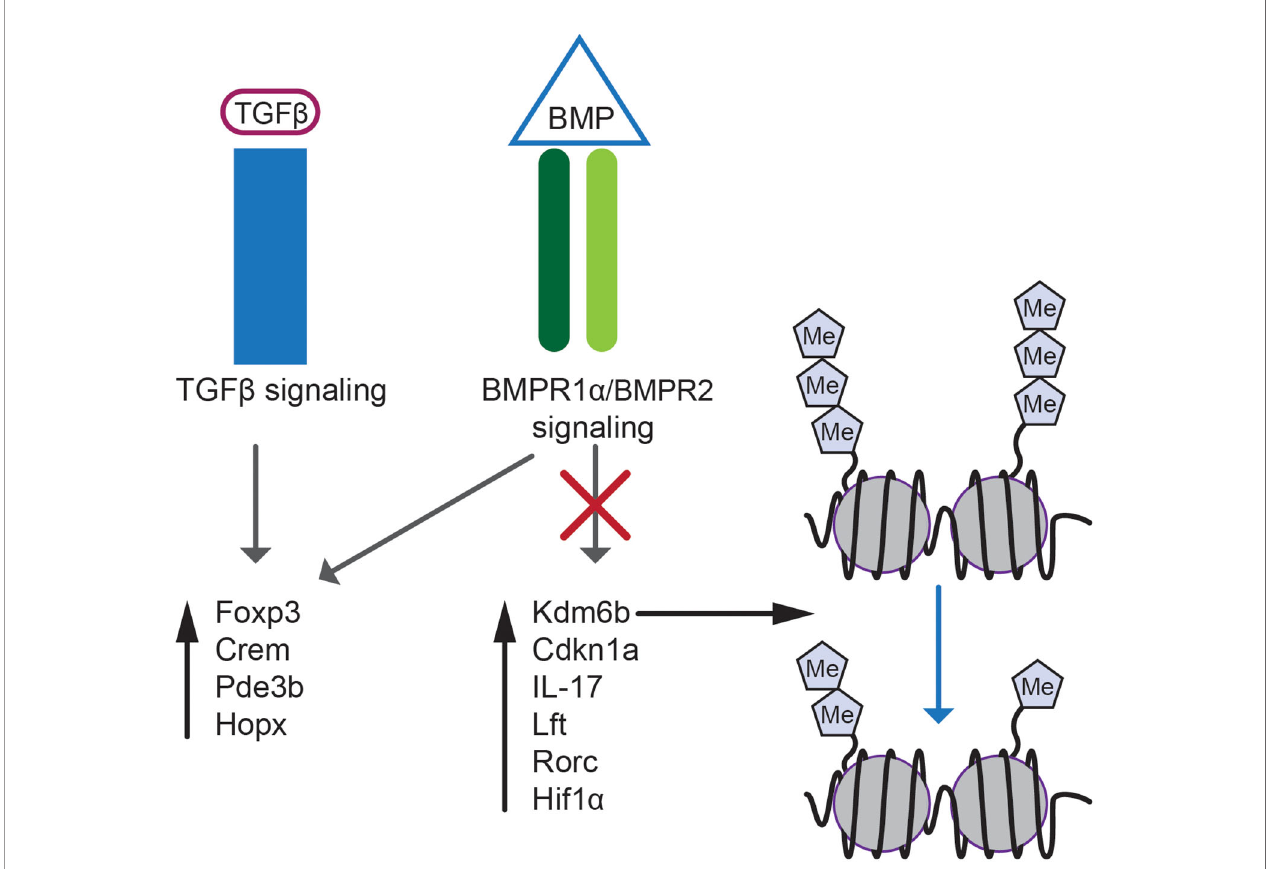
FIGURE 2 | BMP and TGF- b signaling in T reg cell biology. BMP and TGF- b signaling regulates expression of genes essential for T reg lineage speci fi cation e.g. Foxp3, Crem, Pde3b and Hopx. Selective abrogation of BMPR1 a signaling results in altered gene expression and upregulation of Kdm6b, Cdkn1a, IL-17, Lft, Rorc and Hif1 a . Expression of proin fl ammatory genes is regulated by demethylation of inhibitory H3K27m3 epigenetic marks by Kdm6b